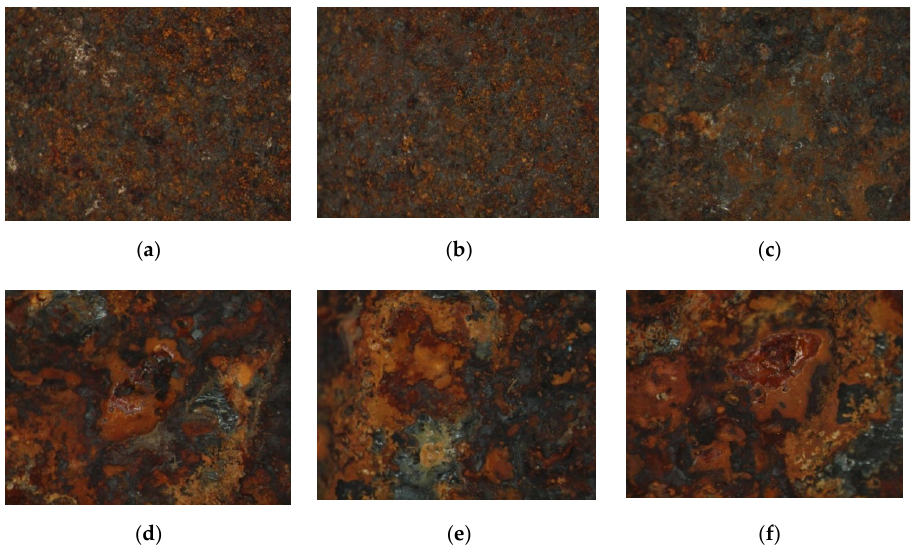
Figure 6. Optical microscope images of specimens exposed to seawater at magnification of 32× for: ( a ) BM, 6 months exposure; ( b ) HAZ, 6 mt.; ( c ) WM, 6 mt.; ( d ) BM, 12 mt.; ( e ) HAZ, 12 mt.; ( f ) WM, 12 mt.